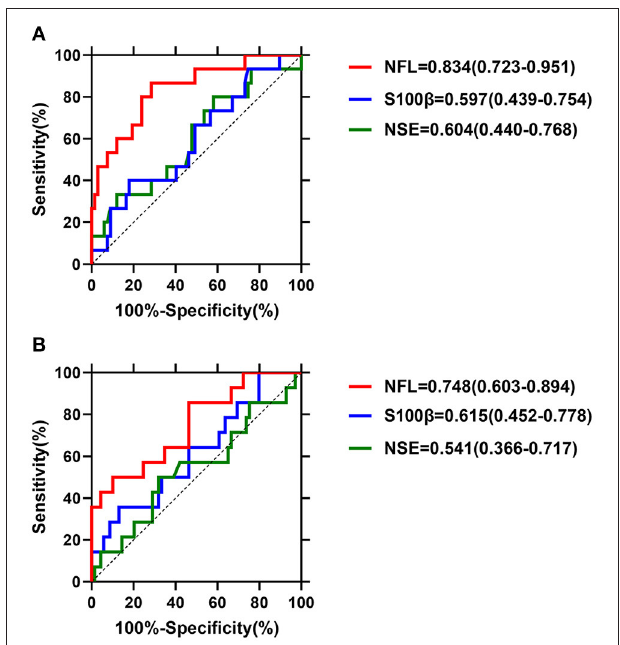
FIGURE 2 | (A,B) Biomarker accuracy for predicting post-operative stroke.